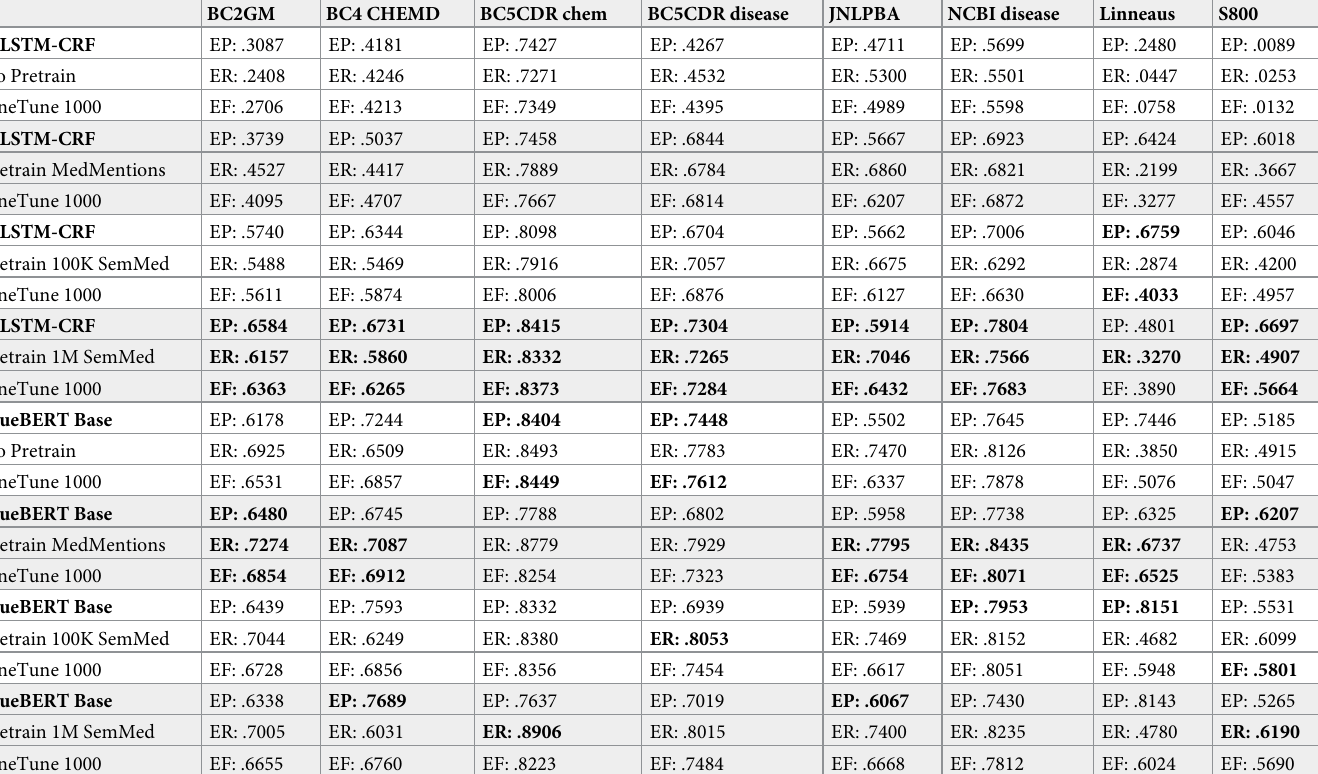
Table 5. Exact precision, recall, and F1 score of the BiLSTM-CRF and BlueBERT on each of our target datasets when pre-trained on different corpora and fine-tun- ing on 1000 labeled sentences (800 train, 200